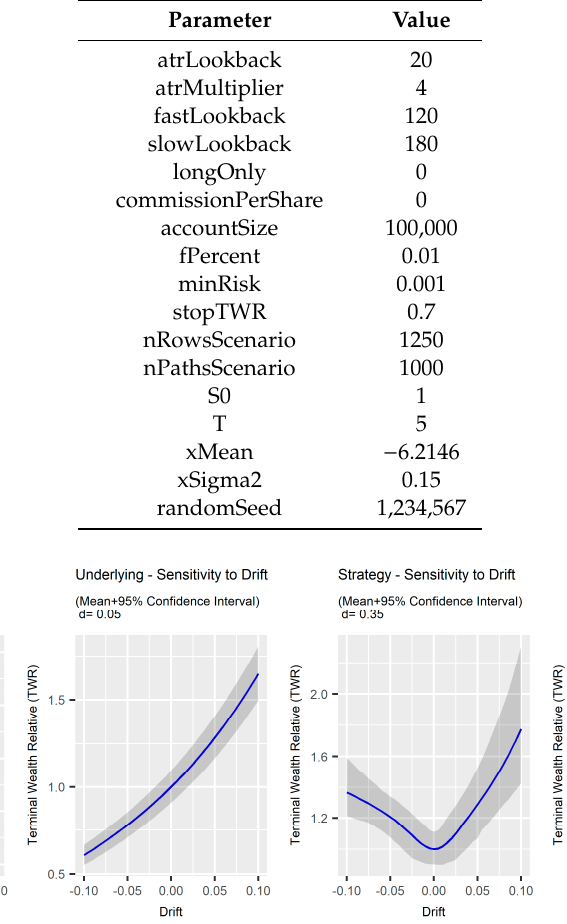
Figure 9. Volatility of price paths .